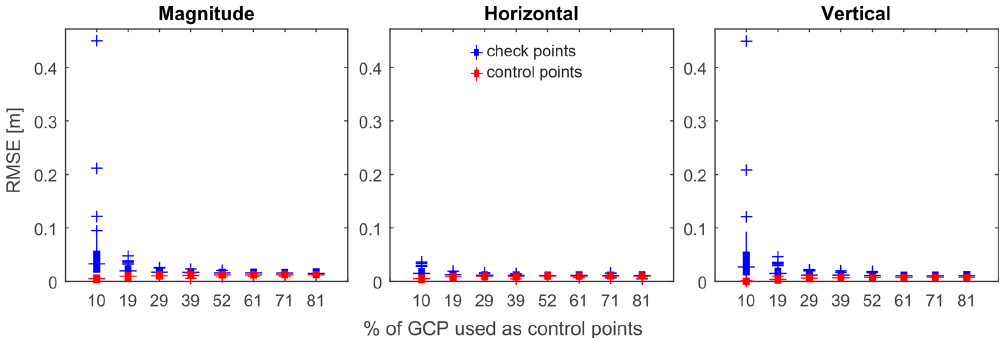
Figure 12. The boxes represent the distribution of the RMSE of GCPs (13 September 2019 survey) on the three components: magnitude (3D), horizontal and vertical according to the percentage of the GCPs used as control points. RMSE is calculated on 50 self-calibrating bundle adjustments for each percentage of GCPs used as control points. The GCPs are randomly selected for each self-calibrating bundle adjustment. The central bars indicate the median RMSE values, which are included in the boxes that extend from the 25th to 75th percentile, and the outliers are indicated by the +